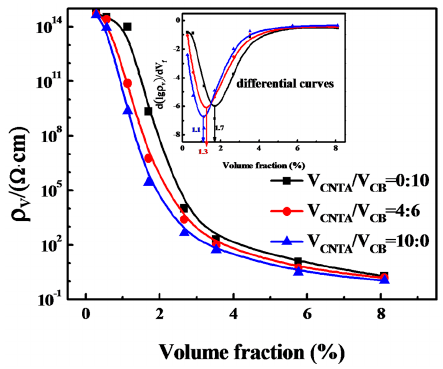
Figure 1. Volume resistivity against the filler volume fraction of CNTA/PMVS, CNTA/CB/PMVS, and CB/PMVS composites.